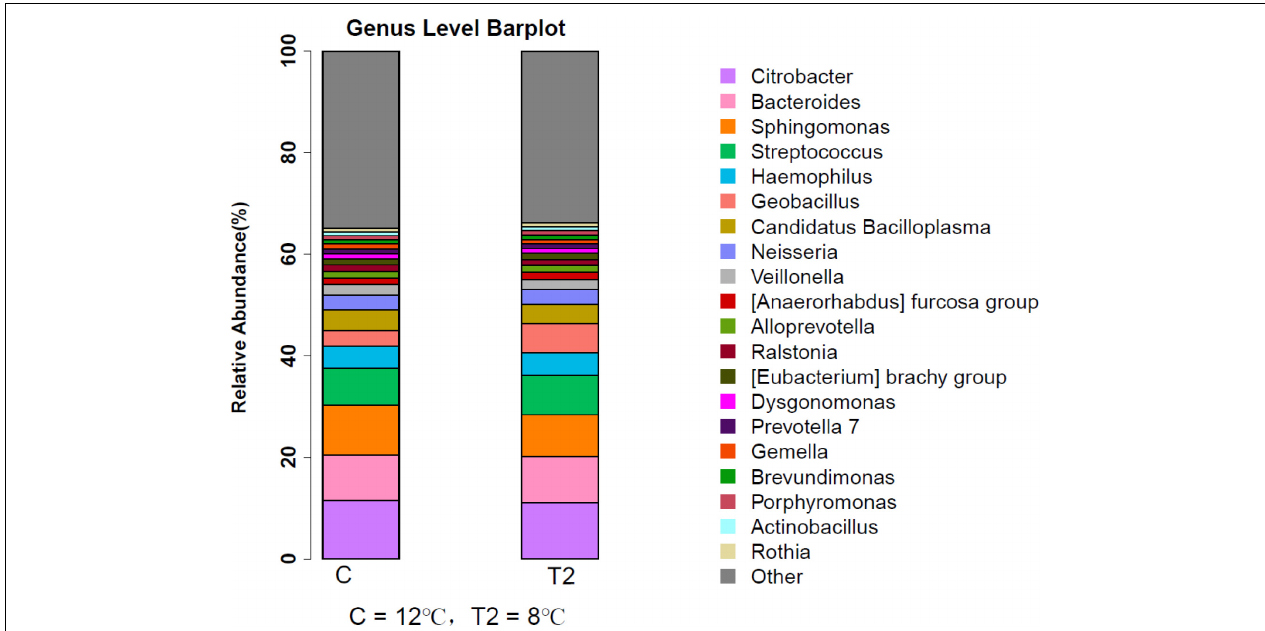
FIGURE 4 | Relative abundance of intestinal microbiota in large yellow croaker by genus. C represents the control group where the fish were kept at 12 ◦ C since the beginning of the experiment and T2 represents the group where the fish were kept at 8 ◦ C for 3 days.